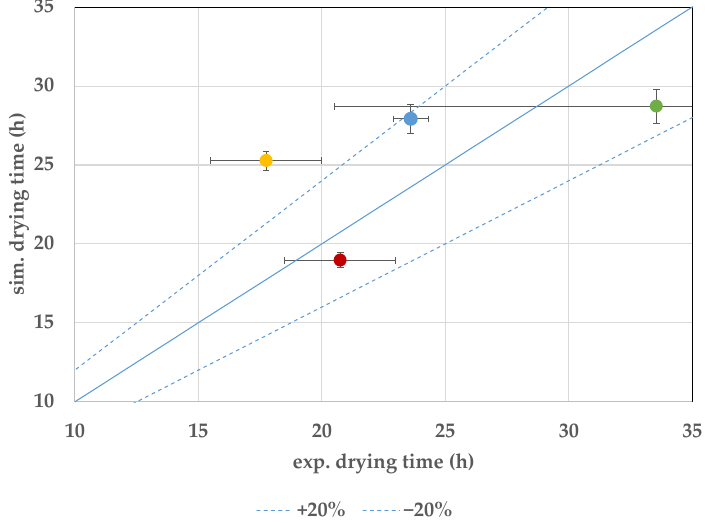
Figure 12. Parity plot between the simulated and experimental primary drying endpoints for the slowest-drying vial (red: + − , yellow: ++, blue: CP, green: −− ).